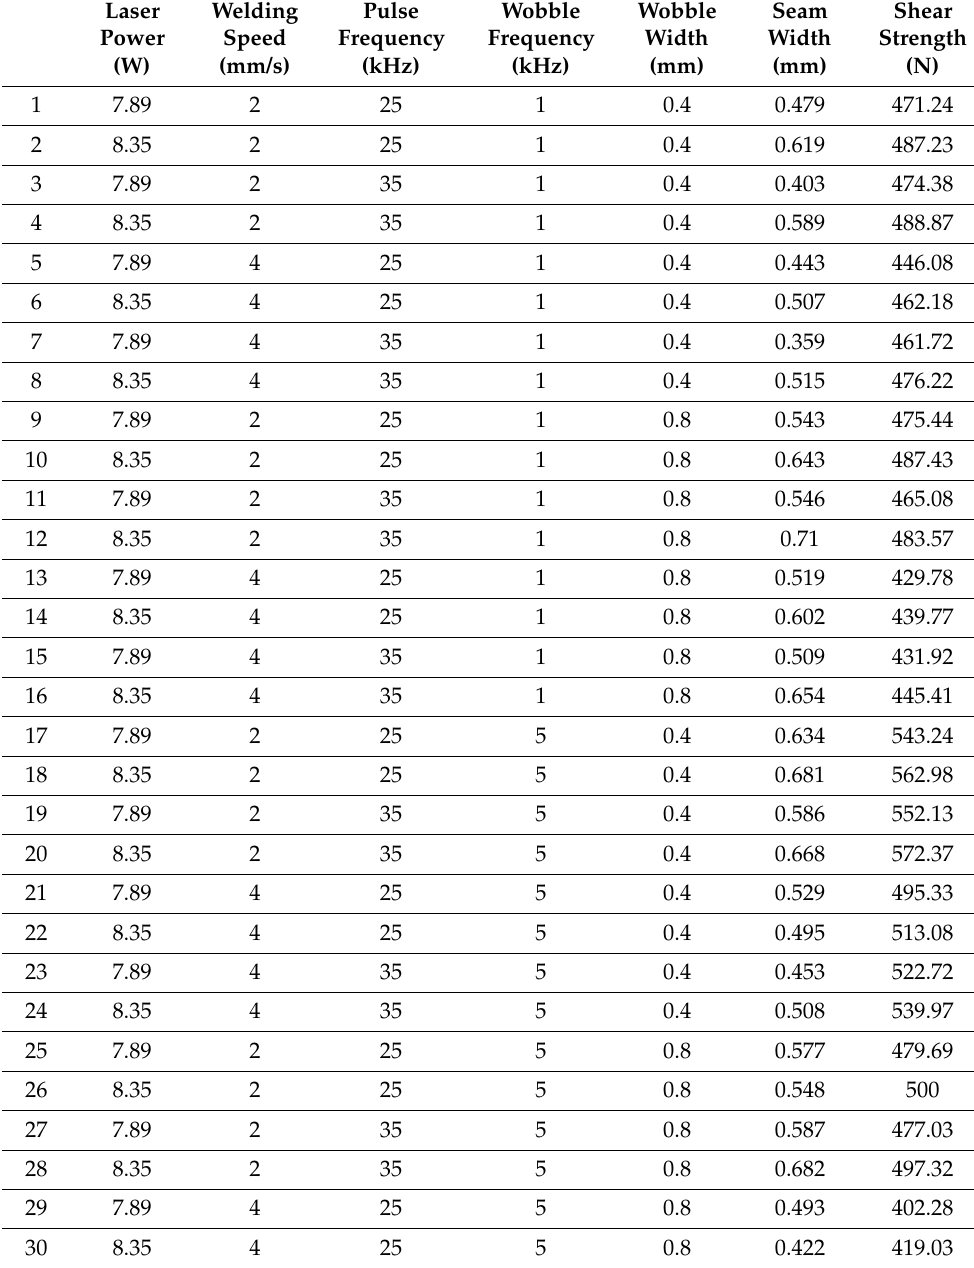
Table 2. Experimental plan